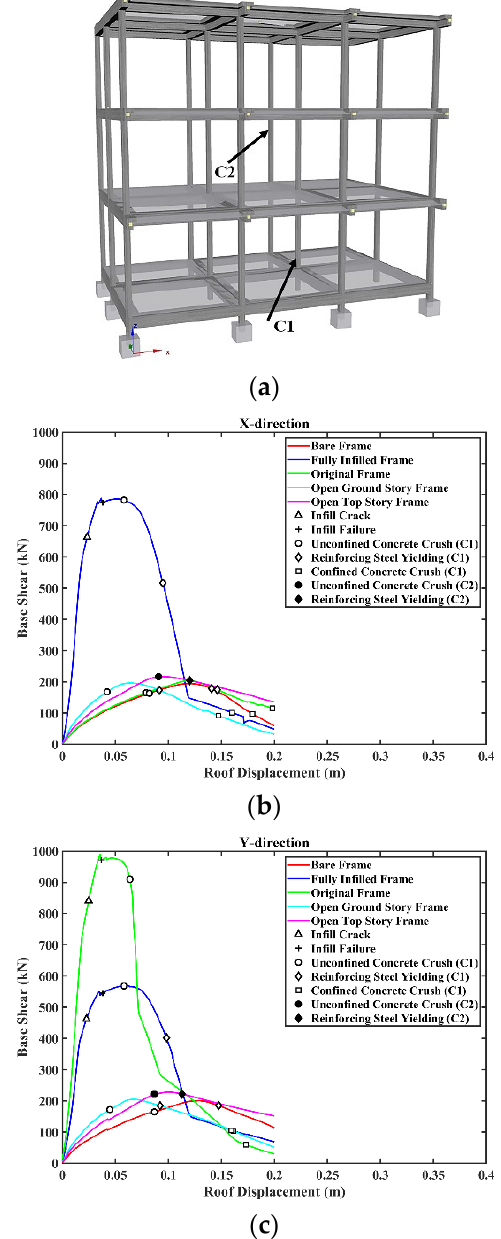
Figure 11. Observed locations and pushover curve of COM: ( a ) Columns C1 and C2; ( b ) x-direction; ( c ) y-direction.